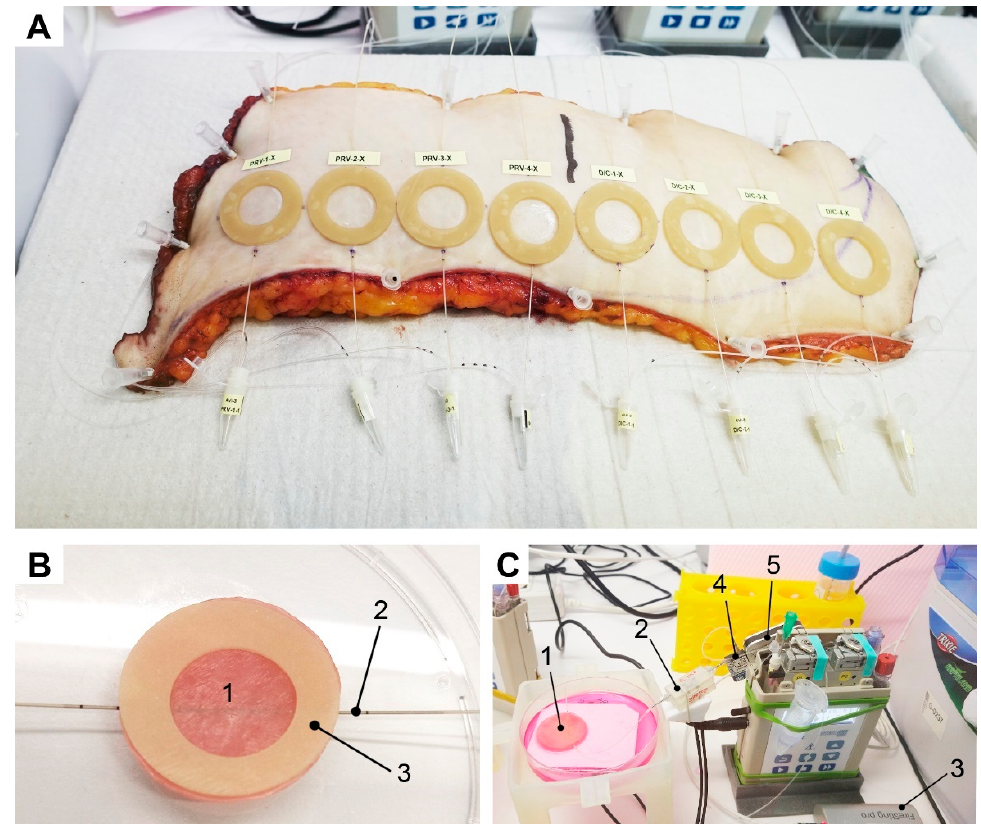
Figure 2. ( A ) Human skin explants with implanted OFM probes, O-shaped patches, and sampling vials. ( B ) Detailed setup of (1) FTSE with (2) an implanted OFM probe and (3) an O-shaped patch to avoid cross-contamination and define the size of the application area. ( C ) Setup of online monitoring (1) FTSE, (2) lead flow-through cell for oxygen and pH, (3) multi-analyte meter FireSting ® -PRO, (4) second flow-through cell for glucose and lactate, and (5) biosensor measuring instrumentation (Six, Jobst Technologies).